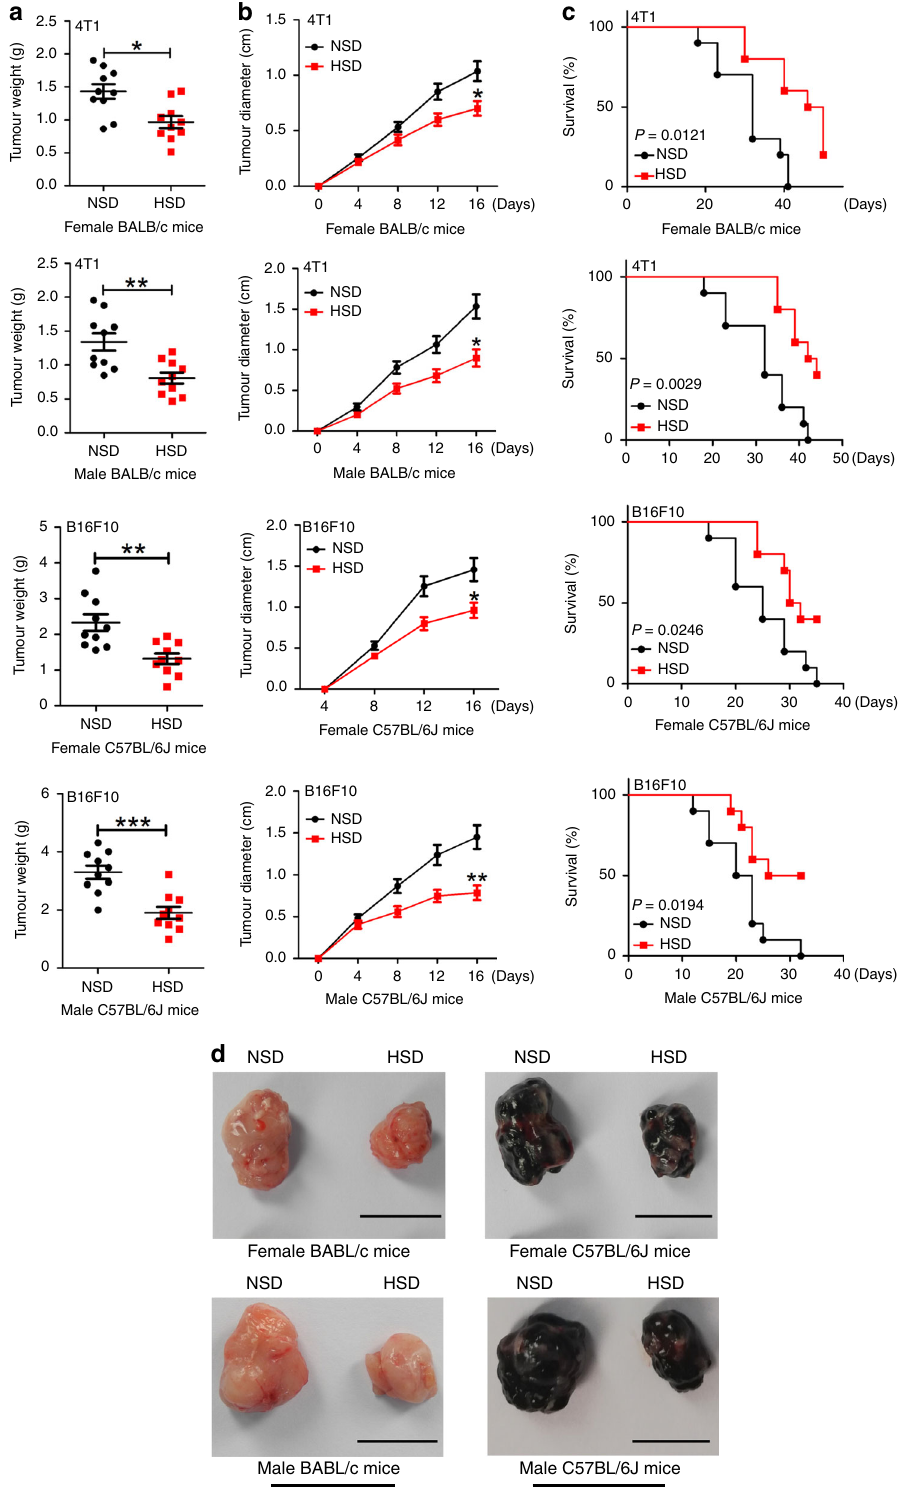
Fig. 1 HSD retarded allograft tumour growth. NSD- or HSD-fed mice were subcutaneously injected with tumour cells until the tumour tissues were harvested. a Tumour weight on day 16 post implantation. b Tumour growth curve from mice on the NSD and HSD for 16 days after tumour cells were engrafted. c Survival rate of tumour-bearing mice in each treatment cohort for more than 5 weeks post implantation. d Representative images of tumours harvested from NSD- and HSD-fed mice. Scale bar, 1 cm. For all panels, the two-tailed Wilcoxon rank-sum tests; n = 10 mice per group; * p < 0.05, ** p < 0.01 and *** p < 0.001 vs. the NSD group. These experiments were replicated with similar results. Data are representative of three independent experiments, and are presented as the mean ± SEM. Source data are provided as a Source Data fi